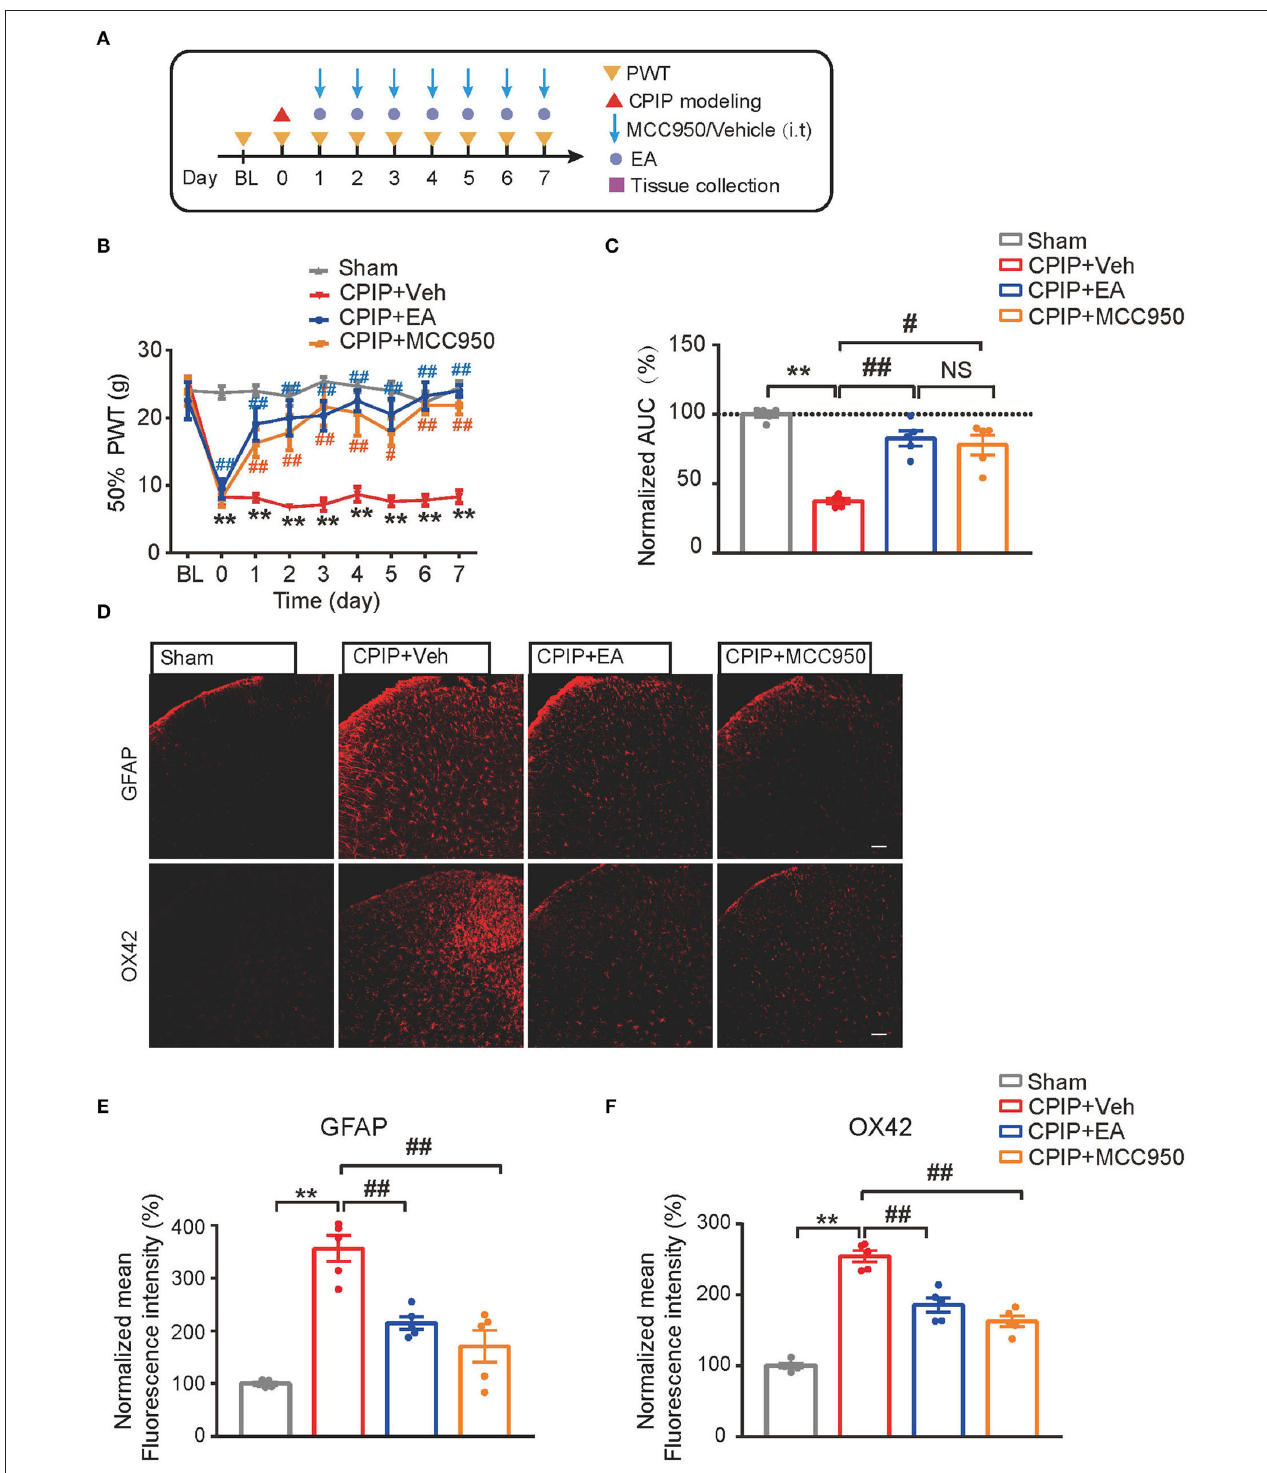
FIGURE 6 | EA’s anti-allodynic effect on CPIP rats is mimicked by pharmacological blocking NLRP3 inflammasome. (A) Experimental protocol. (B) 50% PWT following EA or MCC950 intervention (30 µ g/rat/day, i.t.). (C) Normalized AUC deduced from (B) . (D) Immunostaining showing the effect of EA/MCC950 intervention on astrocyte (Upper panels, marked with GFAP) and microglia overactivation in SCDH. (E,F) Summary of the mean fluorescence intensity of GFAP (E) and OX42 (F) , normalized with the value of sham group. n = 5 rats/group. Scale bar indicates 100 µ m. ** p < 0.01 # p < 0.05, ## p < 0.01. Two-way ANOVA with Tukey’s post-hoc test was applied in panel B. One-way ANOVA with Tukey’s post-hoc test was applied in (C,E,F) . NS, no significance.